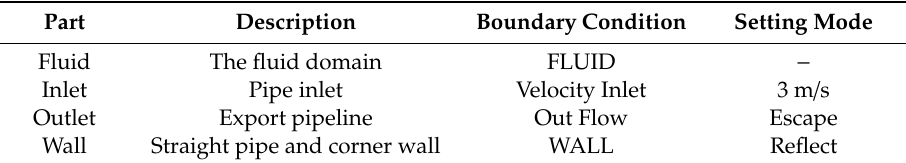
Table 2. Initial boundary conditions in FLUENT.